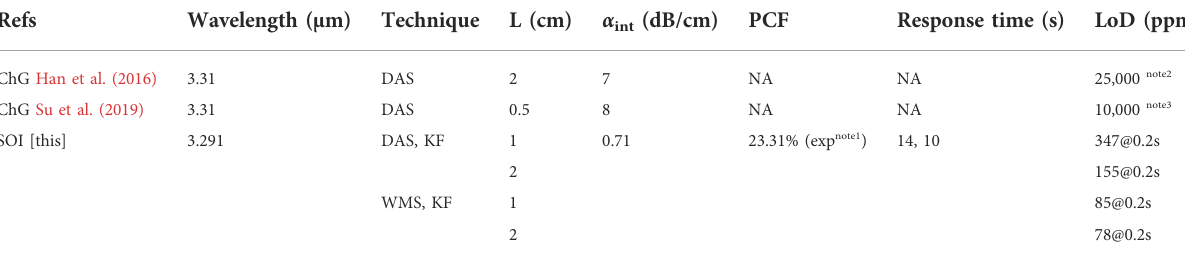
TABLE 1 Comparison among the reported CH 4 waveguide sensors. KF: Kalman fi